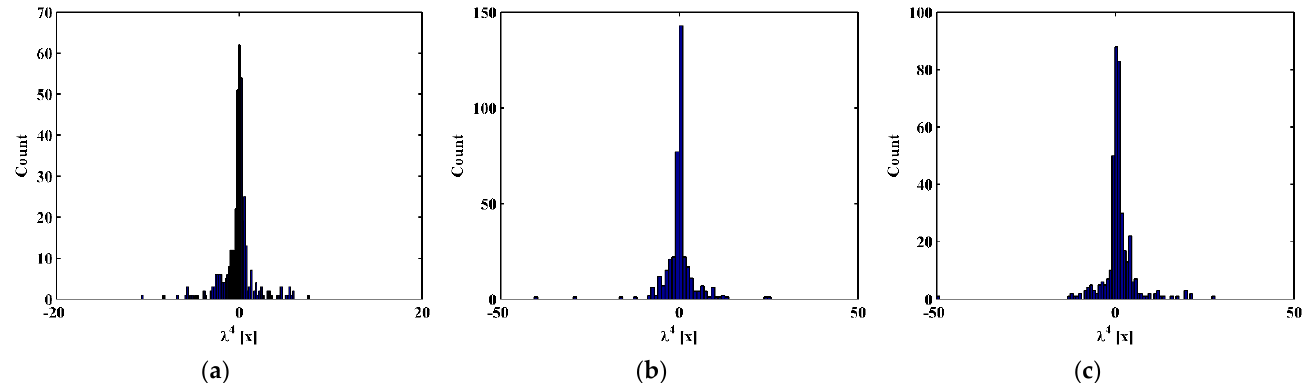
λ λ Figure 17. Distributions of constants 4 [ ] x for the ( a ) third, ( b ) fourth, and ( c ) fifth mode shapes (locations of cracks are Figure 17. Distributions of constants 4 [ ] x for the ( a ) third, ( b ) fourth, and ( c ) fifth mode shapes (locations of cracks are λ Figure 17. Distributions of constants λ 4 [ x ] for the ( a ) third, ( b ) fourth, and ( c ) fifth mode shapes (locations of cracks are Figure 17. Distributions of constants 4 [ ] x for the ( a ) third, ( b ) fourth, and ( c ) fifth mode shapes (locations of cracks are indicated by red lines). indicated by red lines). indicated by red lines). indicated by red lines).